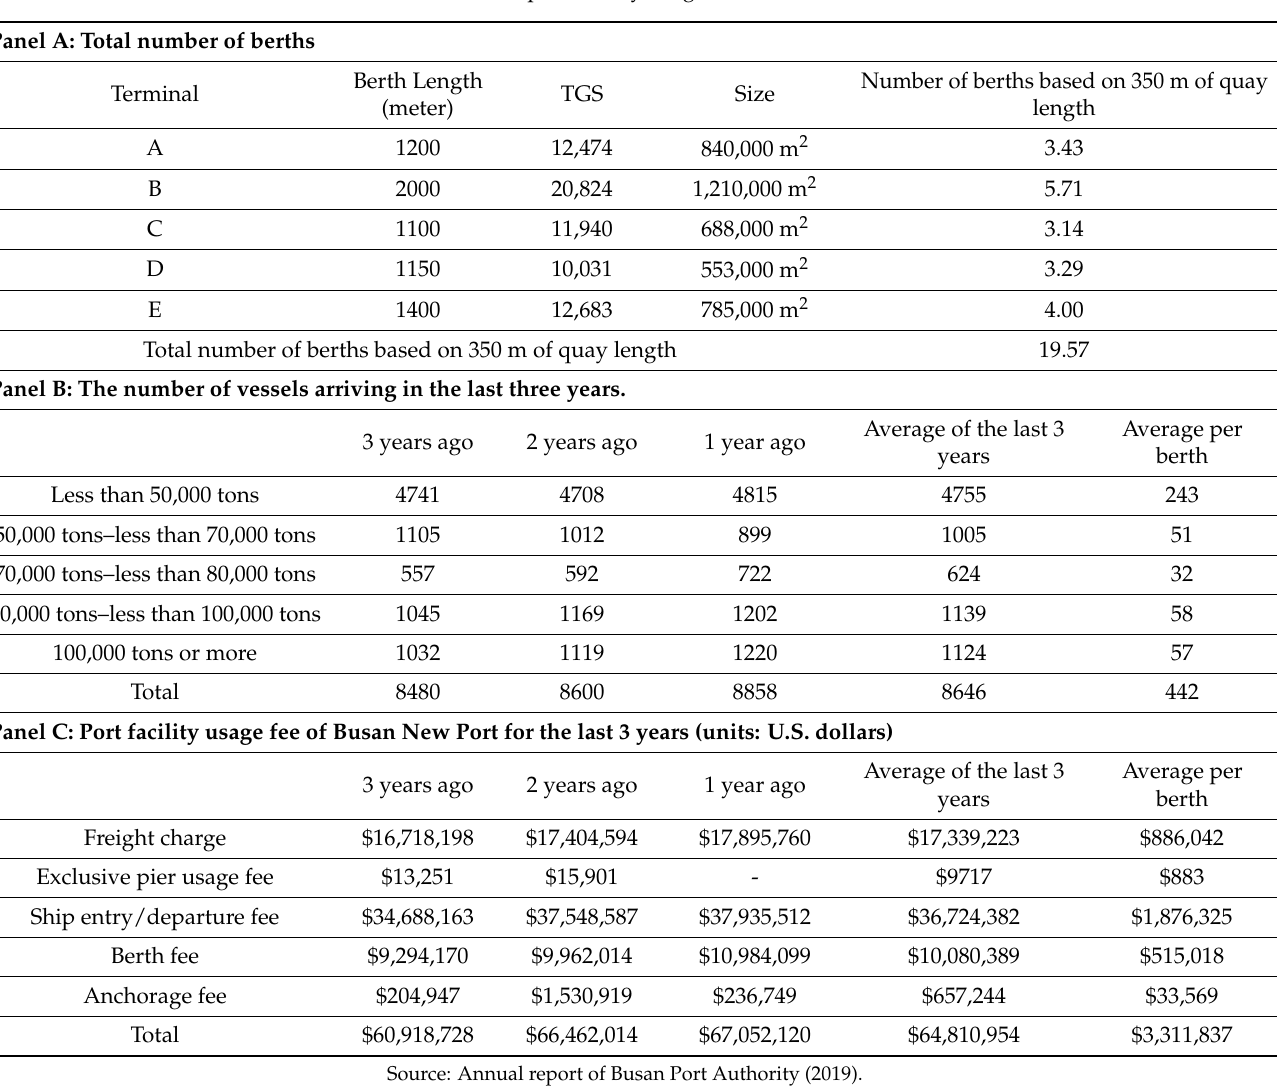
Table 4. Status of port facility usage in Busan New